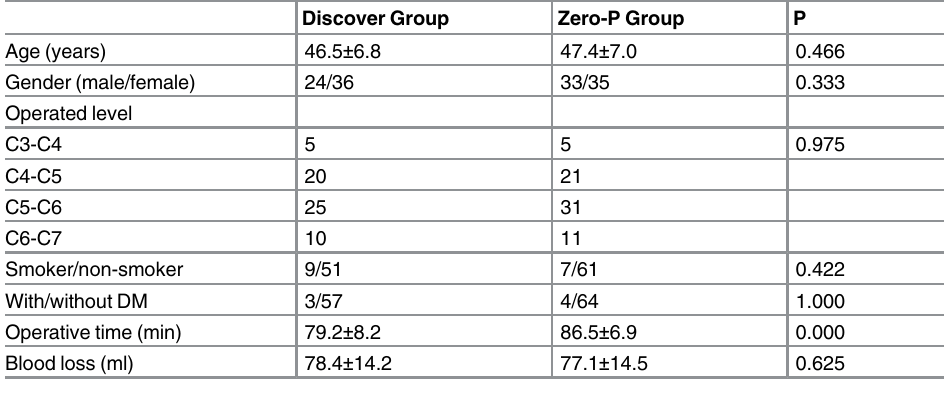
Table 1. Demographic data of